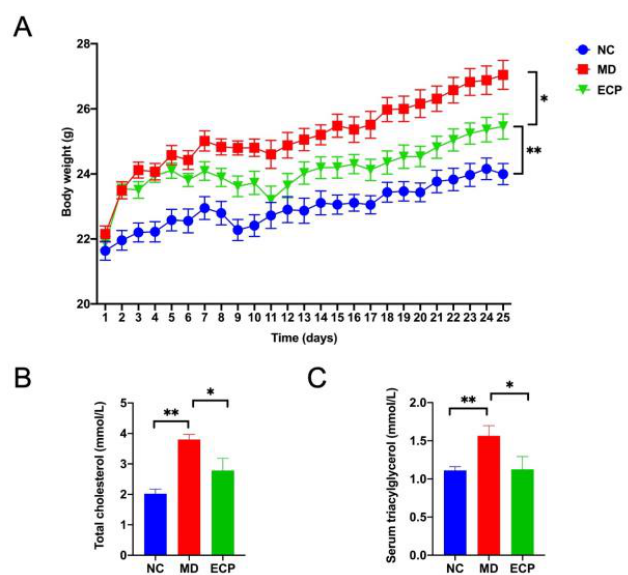
Figure 1. Oral intake of ECP significantly decreased the body weight ( A ), serum levels of triacylglycerol ( B ), cholesterol ( C ) in HFD-fed mice. Data are expressed as means ± standard error of the mean (SEM). * p < 0.05, ** p < 0.01.